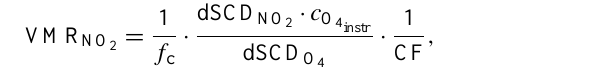
Fig. 2. Retrieval algorithm with NO 2 as example for the trace gas of